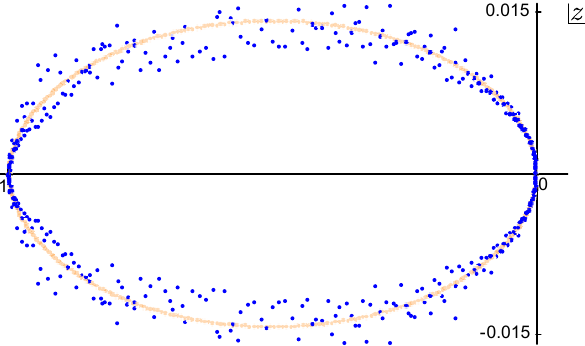
and the maximal spin being 400 with the 4